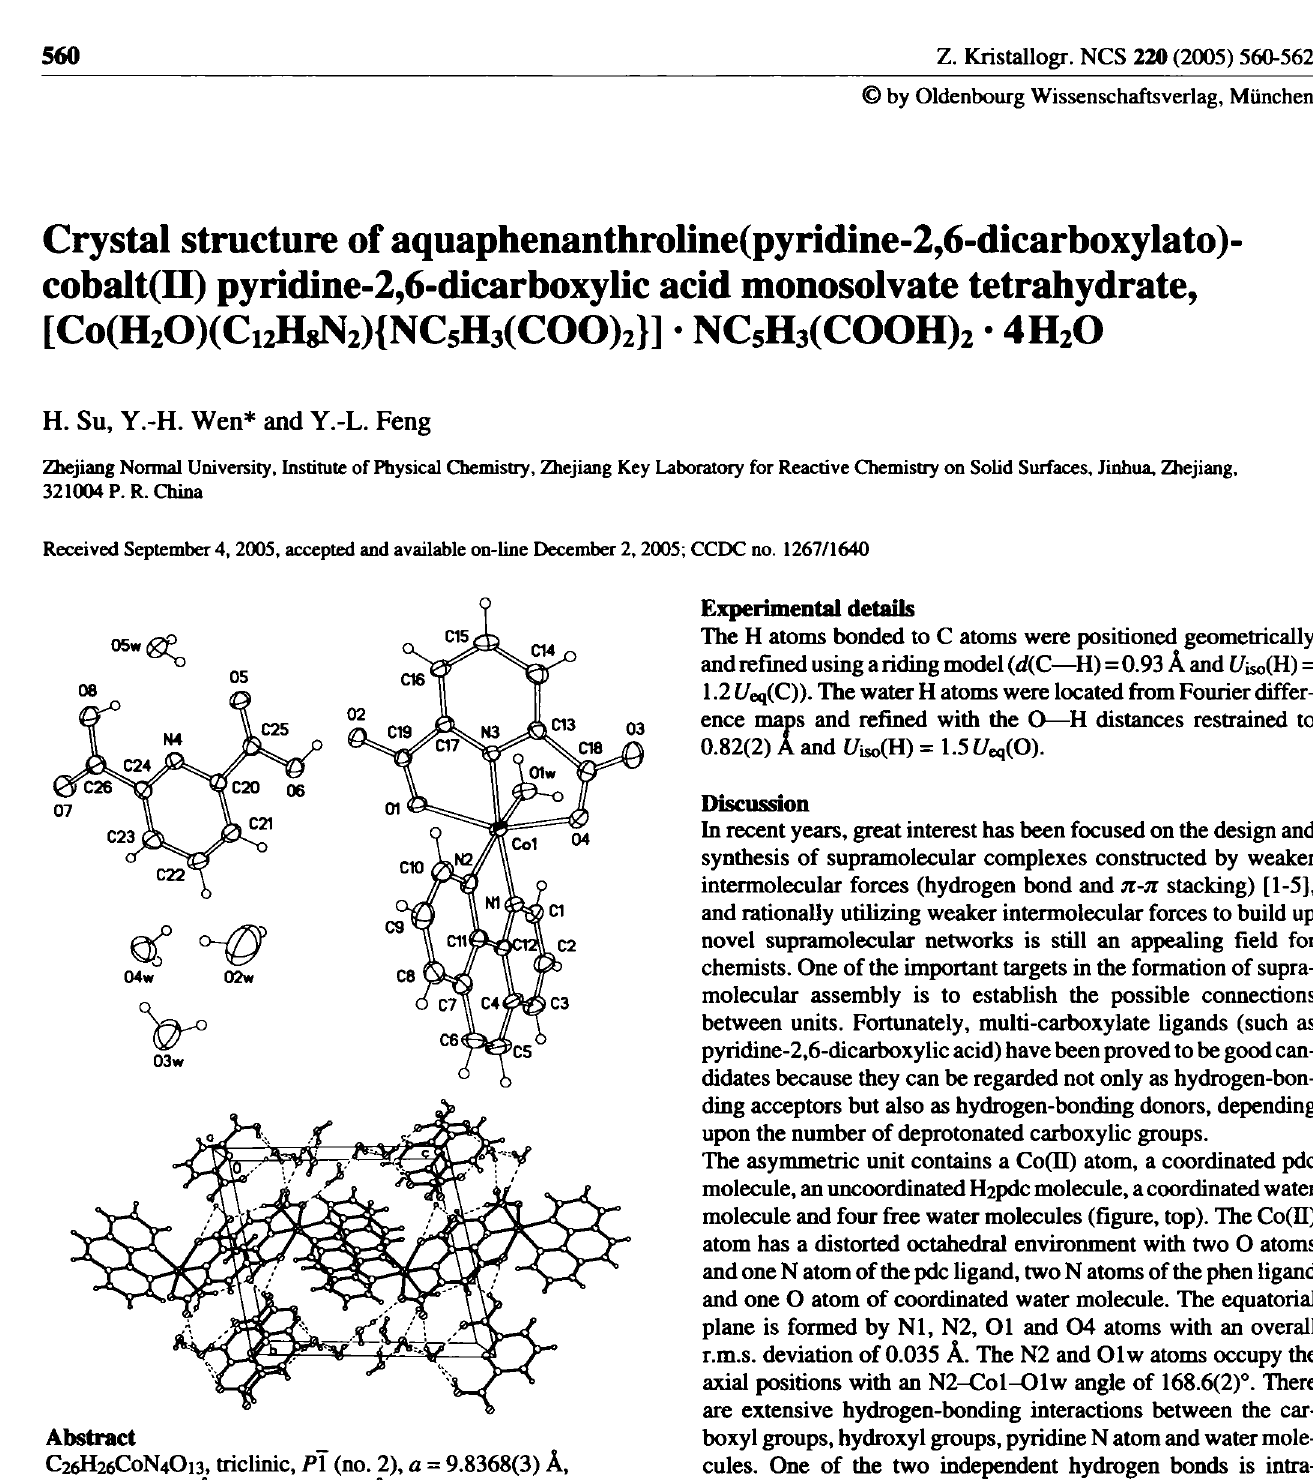
Table 1. Data collection and